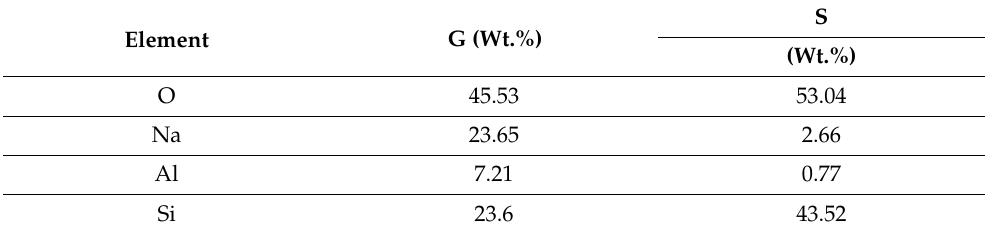
Table 5. EDX analysis results for G and S